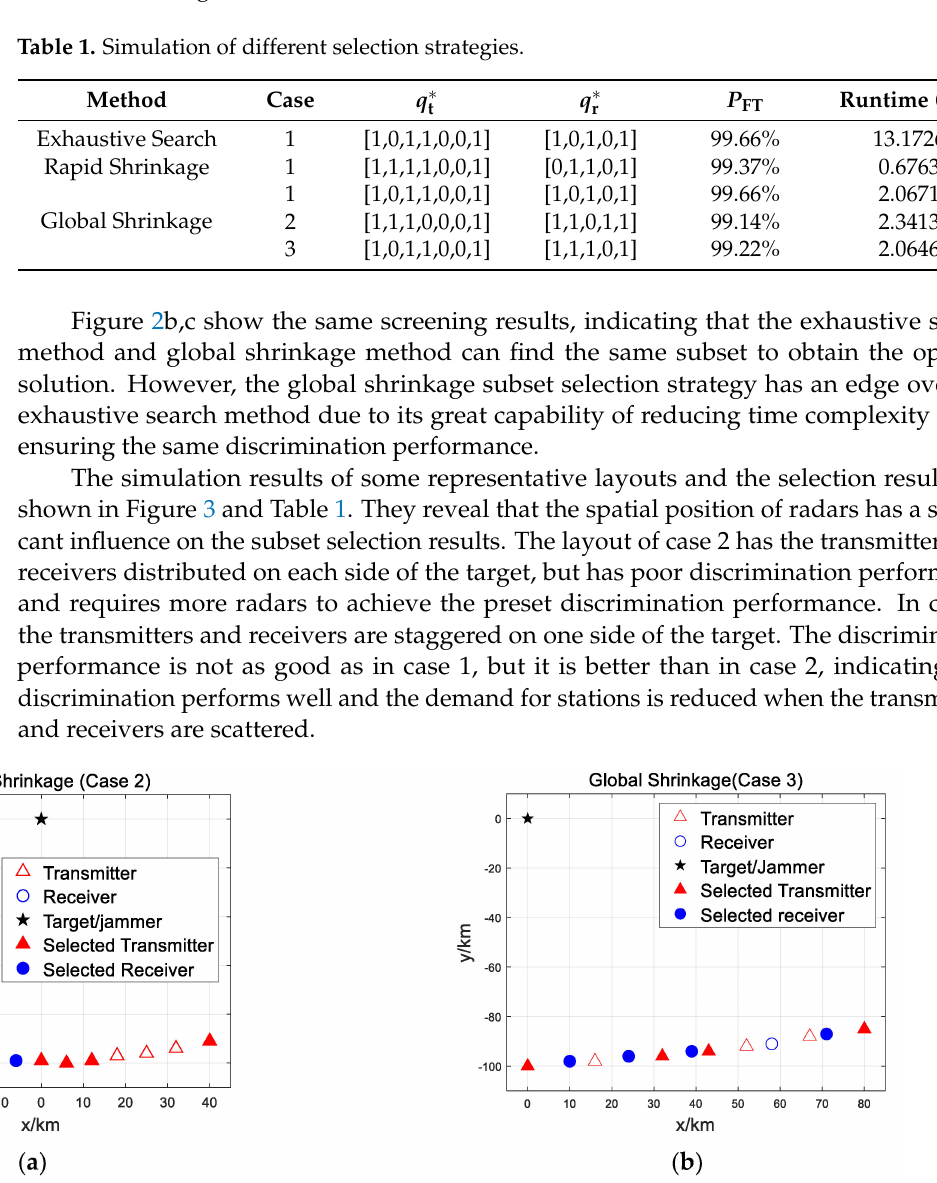
Figure 3. Simulation results for different scenarios: ( a ) global shrinkage strategy in Case 2; ( b ) global shrinkage strategy in Case